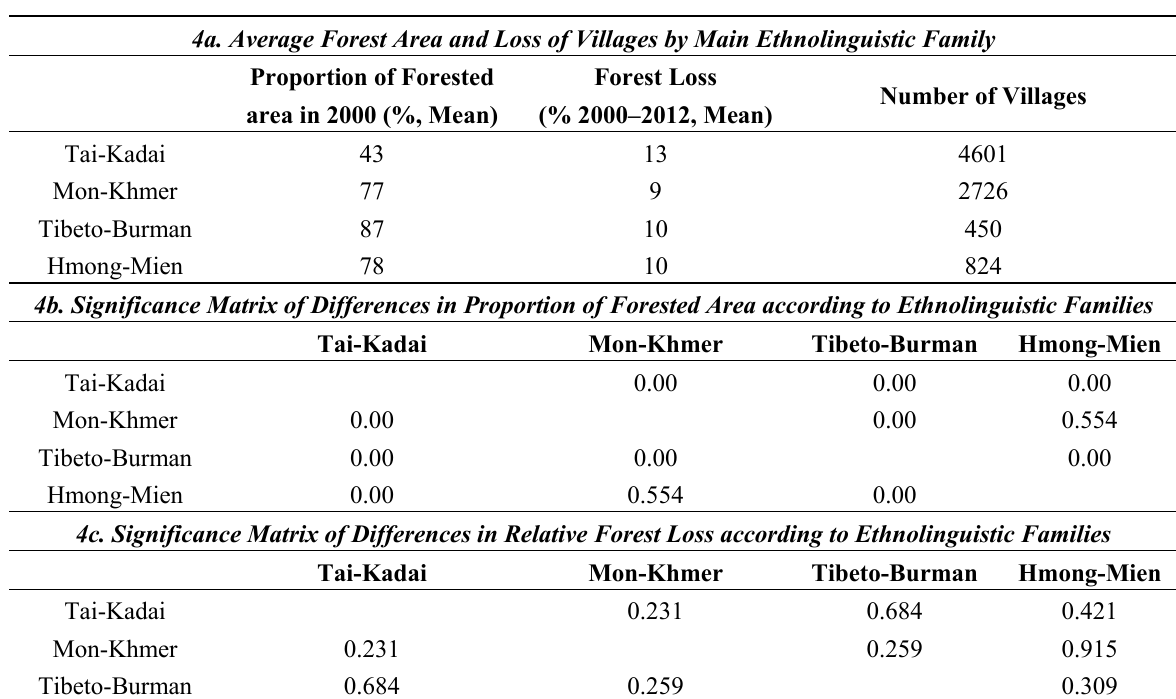
Table 4. Aggregated ethnolinguistic families and forest cover change.